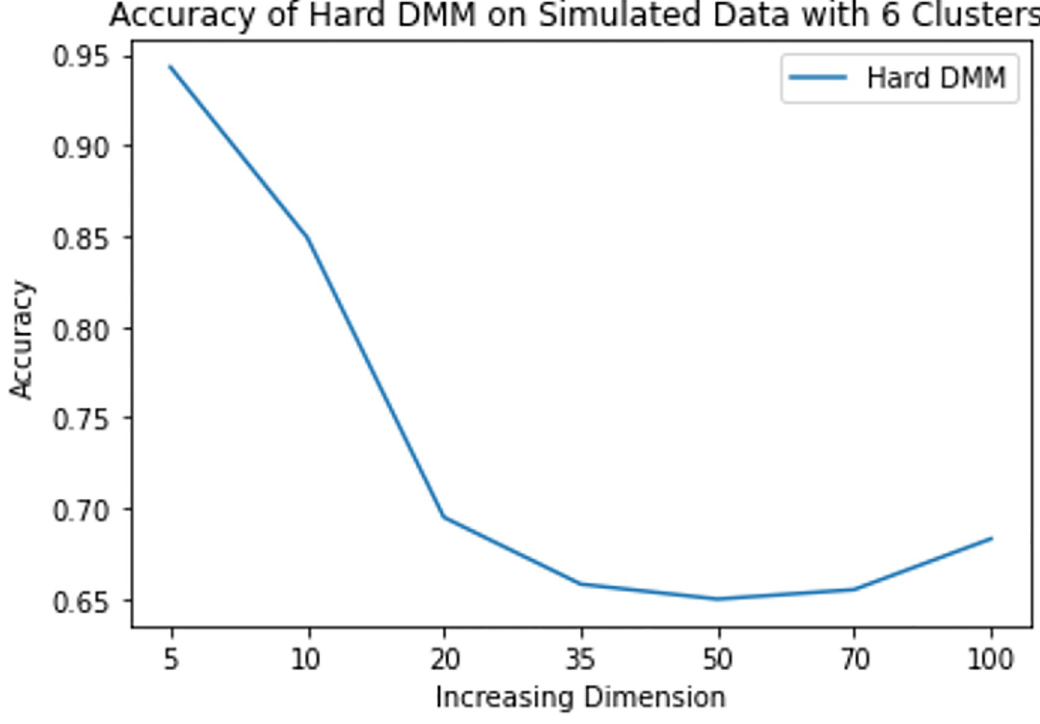
Fig 13. Mean accuracy of hard DMM 1 with 6 clusters, varied dimensions and increasing overlap.